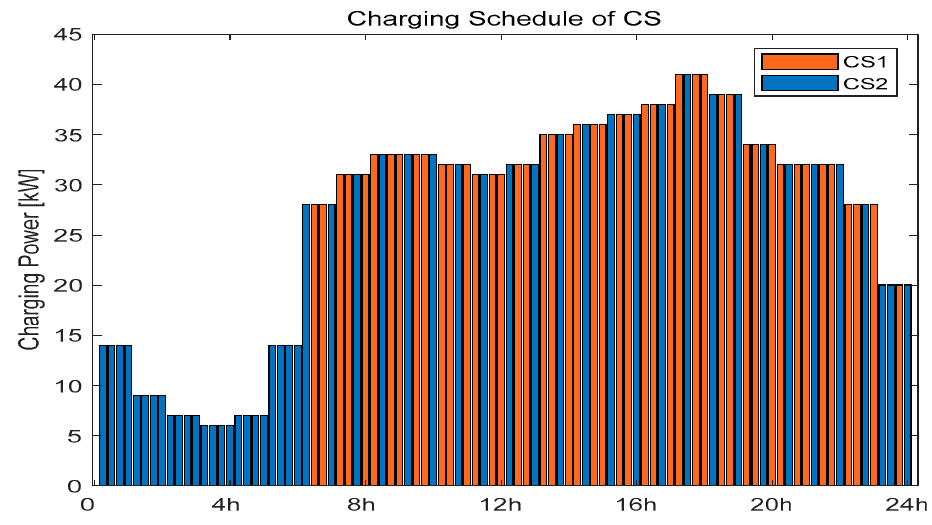
Figure 10. EV’s CS selection rate in Case 2.